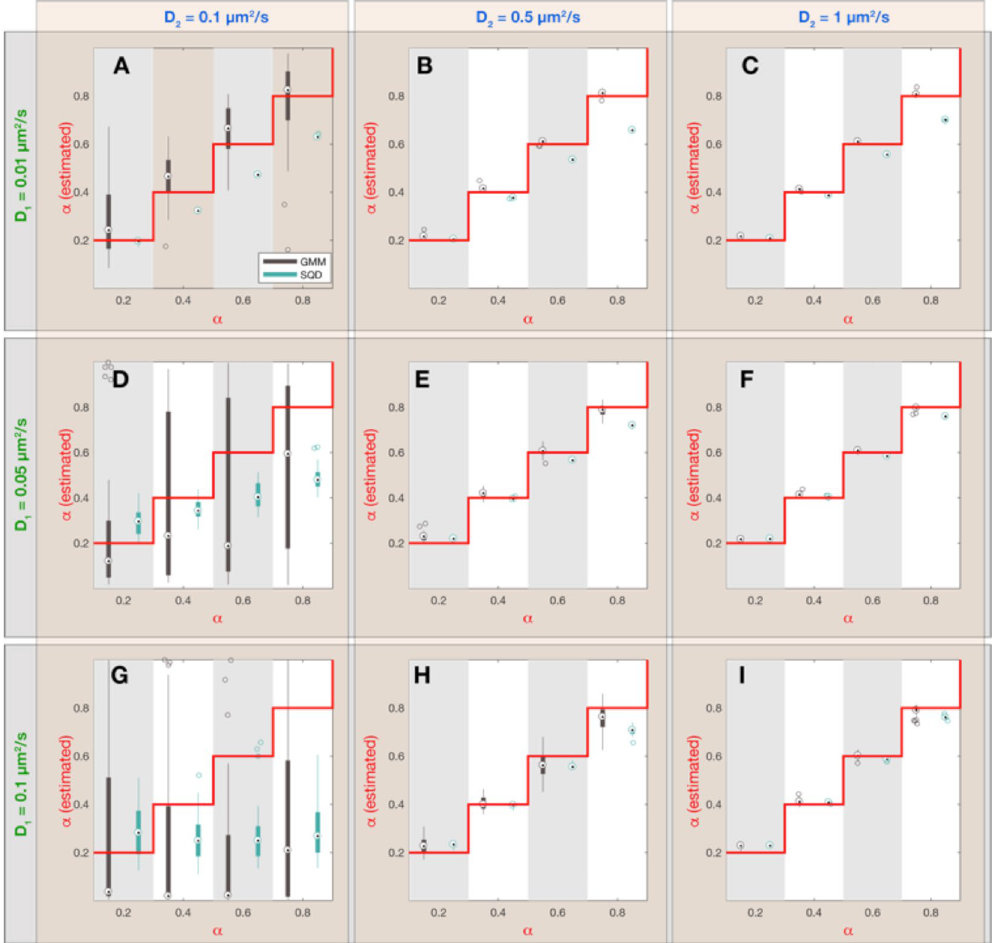
Figure 4. Dependence of estimated fraction α (slow subpopulation) on simulation parameters and inference method. Each panel (A–I) corresponds to a combination of simulation parameters D green and blue labels outside the plot panels, respectively. Within each panel 4 values of the fraction sizes α were chosen and synthetic simulations were performed on all parameter combinations. For each parameter combination ( D , D and α ) 30 simulations with 2000 tracks of 20 frames duration (see Table 1 for all simulation 1 2 parameters) were executed and the resulting data was analyzed with the GMM and SQD method, yielding two different estimates for the value of α (GMM: black boxplots; SQD: cyan boxplots). On each box, the central mark is the median, the edges of the box are the 25 th and 75 th percentiles, the whiskers extend to the most extreme data points not considered outliers and the outliers are plotted as individual circles. The red lines indicate the true values for α in the